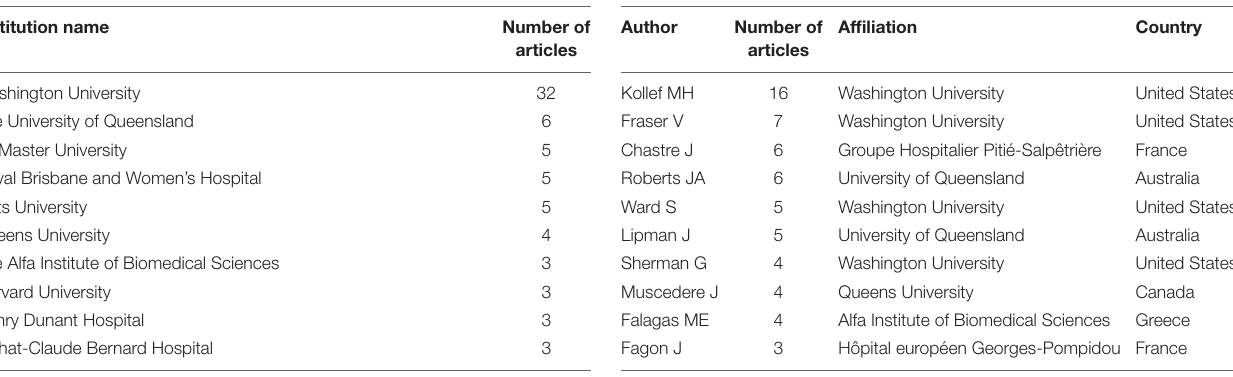
TABLE 1 | Institutions contributing to the 100 most-cited articles. TABLE 2 | Top 10 authors most frequently appearing in the